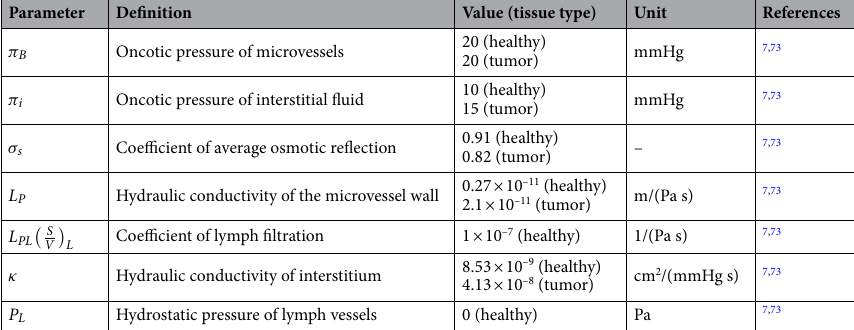
Table 1. Parameters of interstitial transport used in numerical